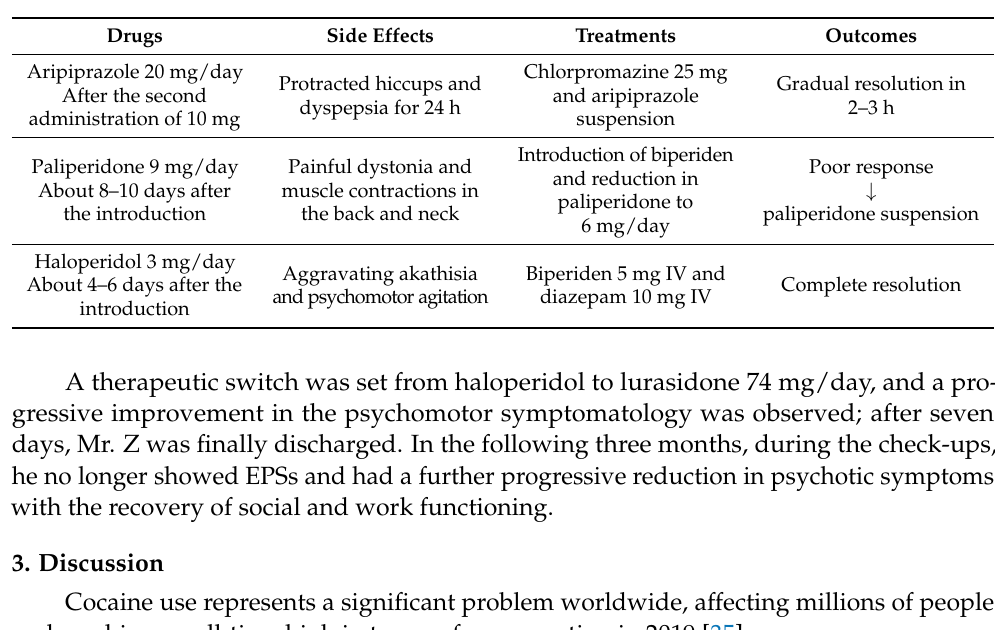
Table 1. Pharmacological therapy, side effects, treatments, and